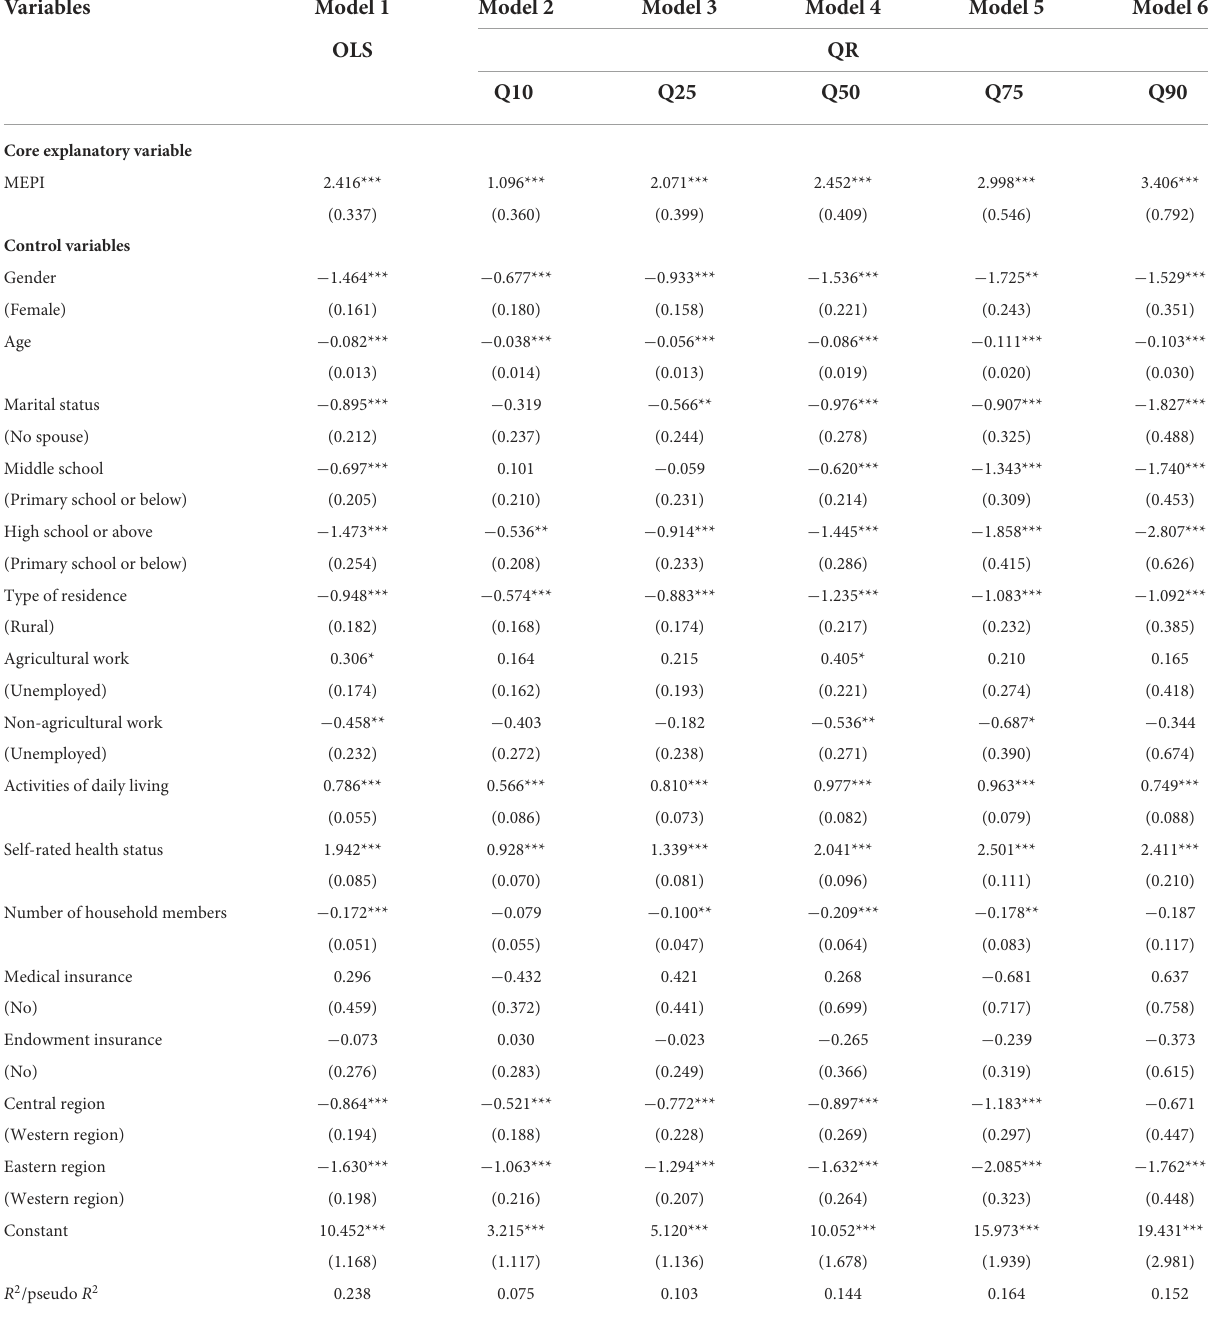
TABLE 3 Regression results of the relationship between multidimensional energy poverty and depression